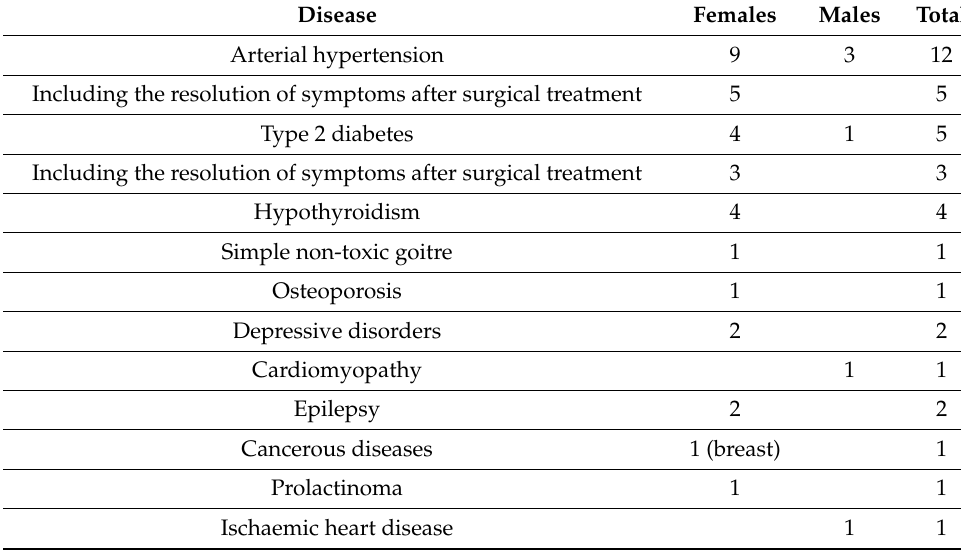
Table 5. Diseases accompanying obesity in the examined population. Disease Females Males Total Arterial hypertension 9 3 12 Including the resolution of symptoms after surgical treatment 5 5 Type 2 diabetes 4 1 5 Including the resolution of symptoms after surgical treatment 3 3 Hypothyroidism Simple non-toxic goitre